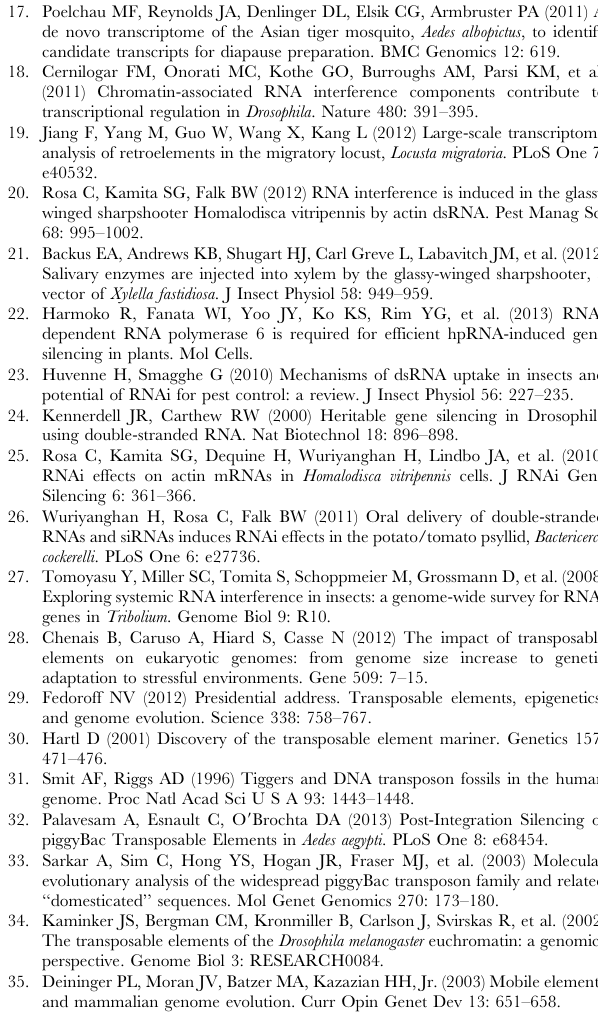
Table S2 Table containing top BLAST hits. The table here contains a list of top blast hits found for the contigs of H. vitripennis transcriptome using a TBLASTX homology. Table S3 Table summary containing Interpro-scan results. The table here contains the summary results of Interpro-scan results for the contigs of H. vitripennis